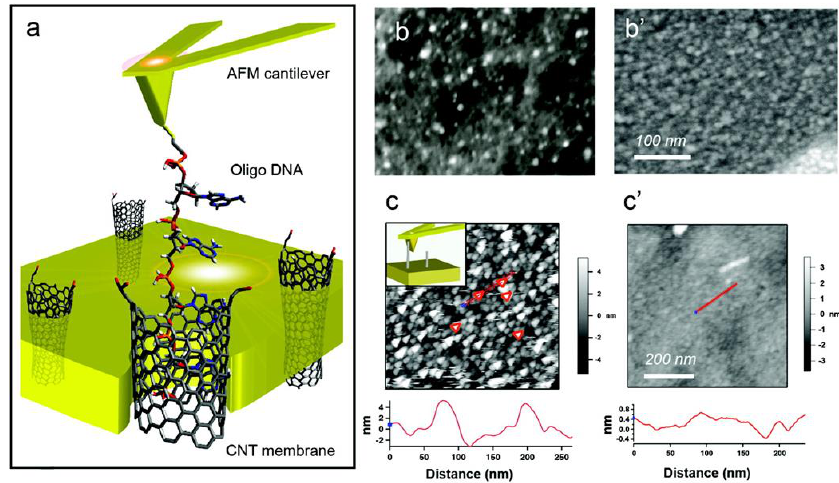
Figure 5. Frictionless sliding of ssDNA in CNT pore. ( a ) Schematic view. CNTs were vertically aligned in a rigid polymer matrix; ( b ) High-resolution scanning electron microscopy (SEM) image and ( c ) AFM image of the CNT membrane. ( b’ ) SEM image and ( c’ ) AFM image of control polymer film sample. Bottom cross-sections correspond to red lines on AFM images (reprinted from reference [76] with permission).